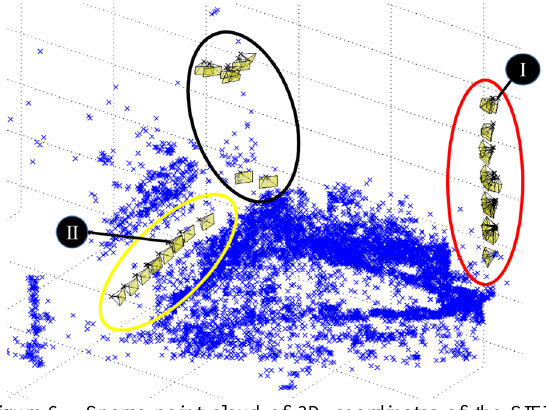
Figure 6. Sparse point cloud of 3D coordinates of the SIFT- Features and camera positions. Image I and II are shown in Figure 5.